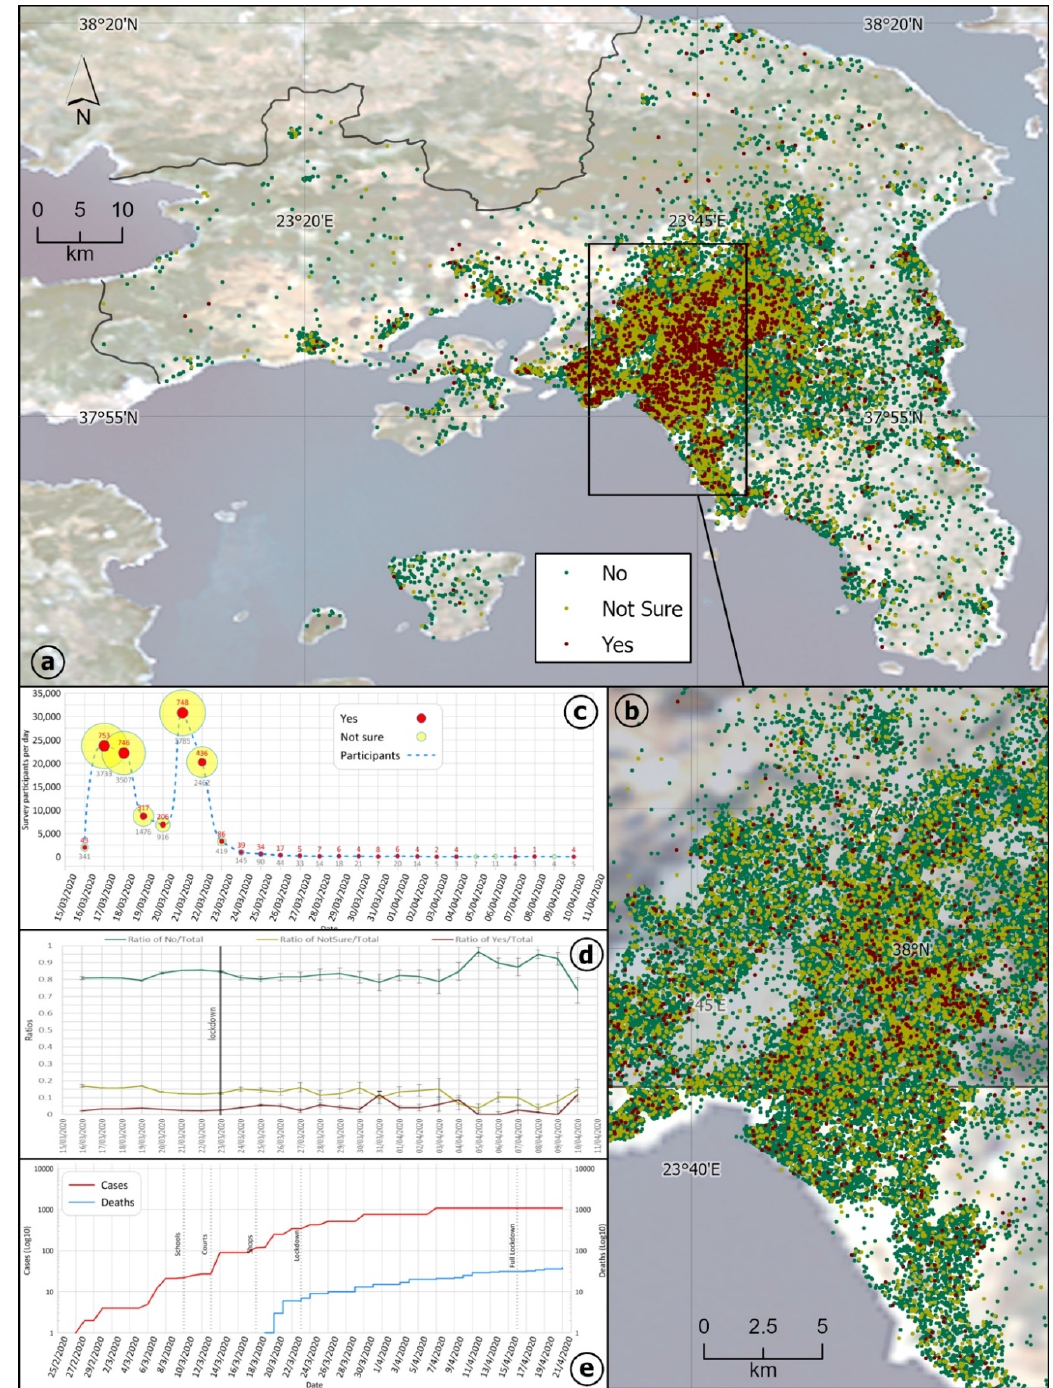
Figure 5. Spatial distribution of survey entries for ( a ) the Region of Attica and ( b ) the Athens metropolitan area. Temporal evolution for the Region of Attica of ( c ) the number of participants per day with the number of Yes and Not Sure annotated, ( d ) ratios of the three different answers per day (left axis), compared to the confirmed cases (number/day; right axis), ( e ) the confirmed cases and deaths per day in Attica since the recording of the first confirmed case in Greece. Critical restriction of activities is also indicated with vertical solid or dashed lines.